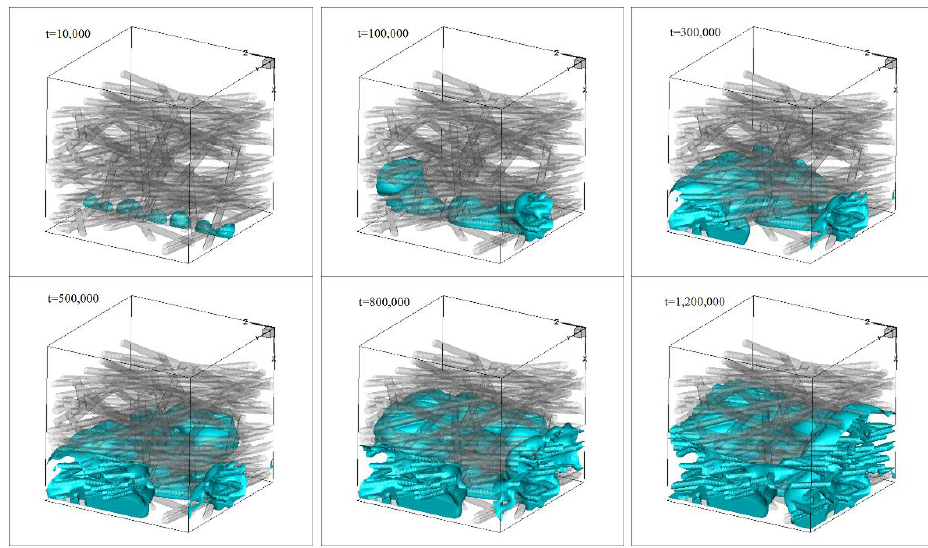
Figure 3. Time evolutions of liquid water in the computational domain.